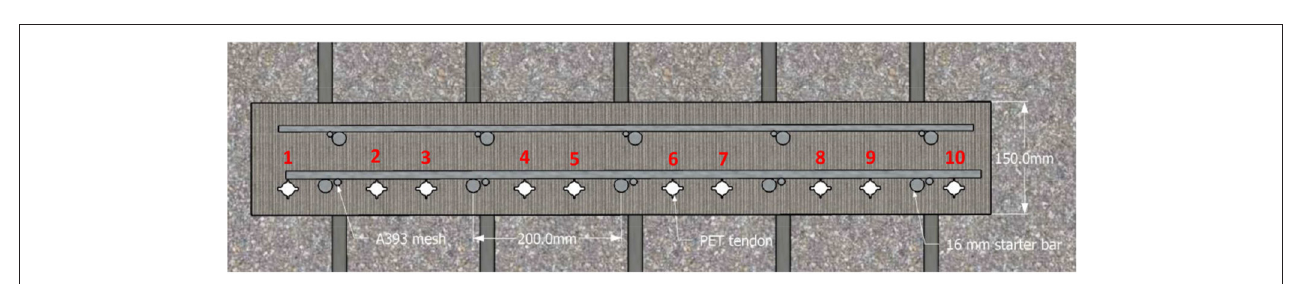
FIGURE 7 | Cross-section of Panel B layout with PET